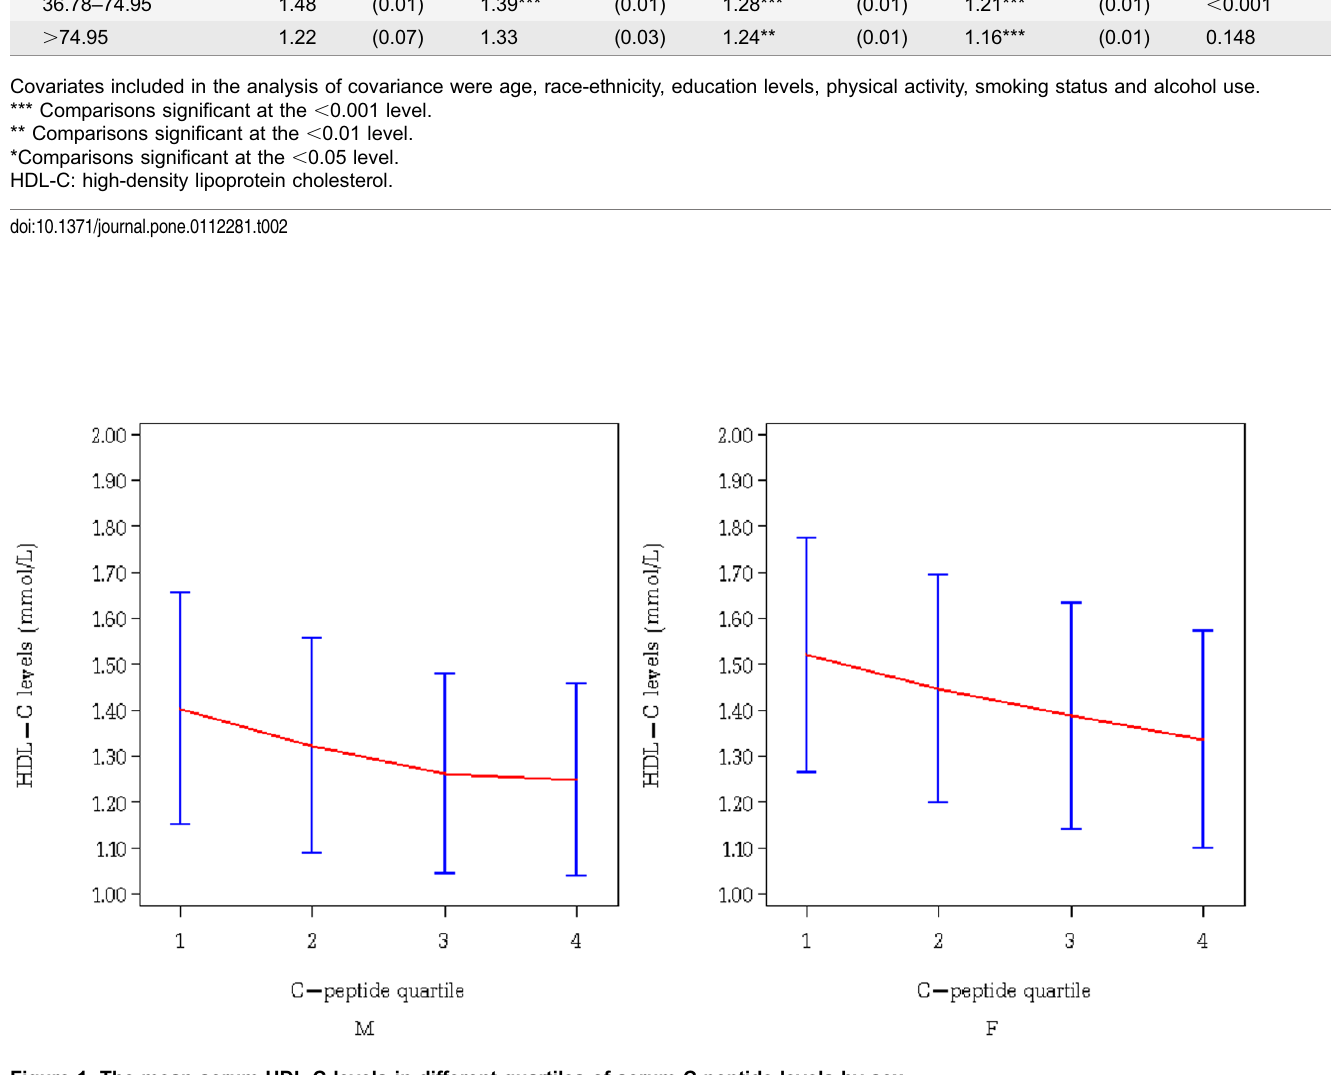
Figure 1. The mean serum HDL-C levels in different quartiles of serum C-peptide levels by